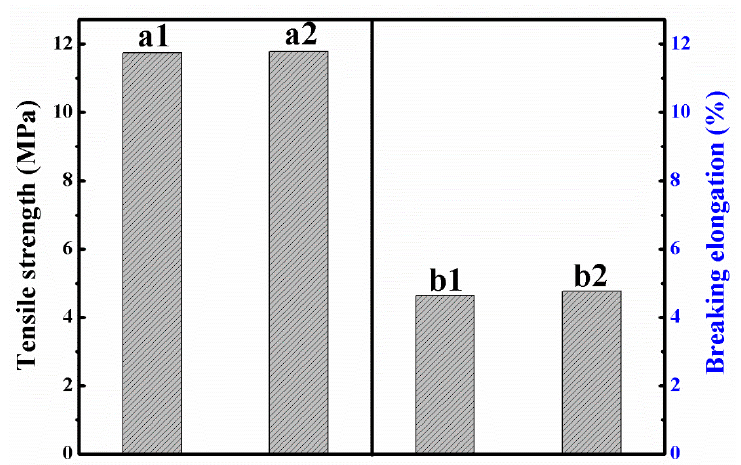
Figure 10. Tensile strength: ( a1 ) original MC / PLA (1:1) membrane; ( a2 ) recovered MC / PLA (1:1) membrane. Breaking elongation: ( b1 ) original MC / PLA (1:1) membrane; ( b2 ) recovered MC / PLA (1:1) membrane.